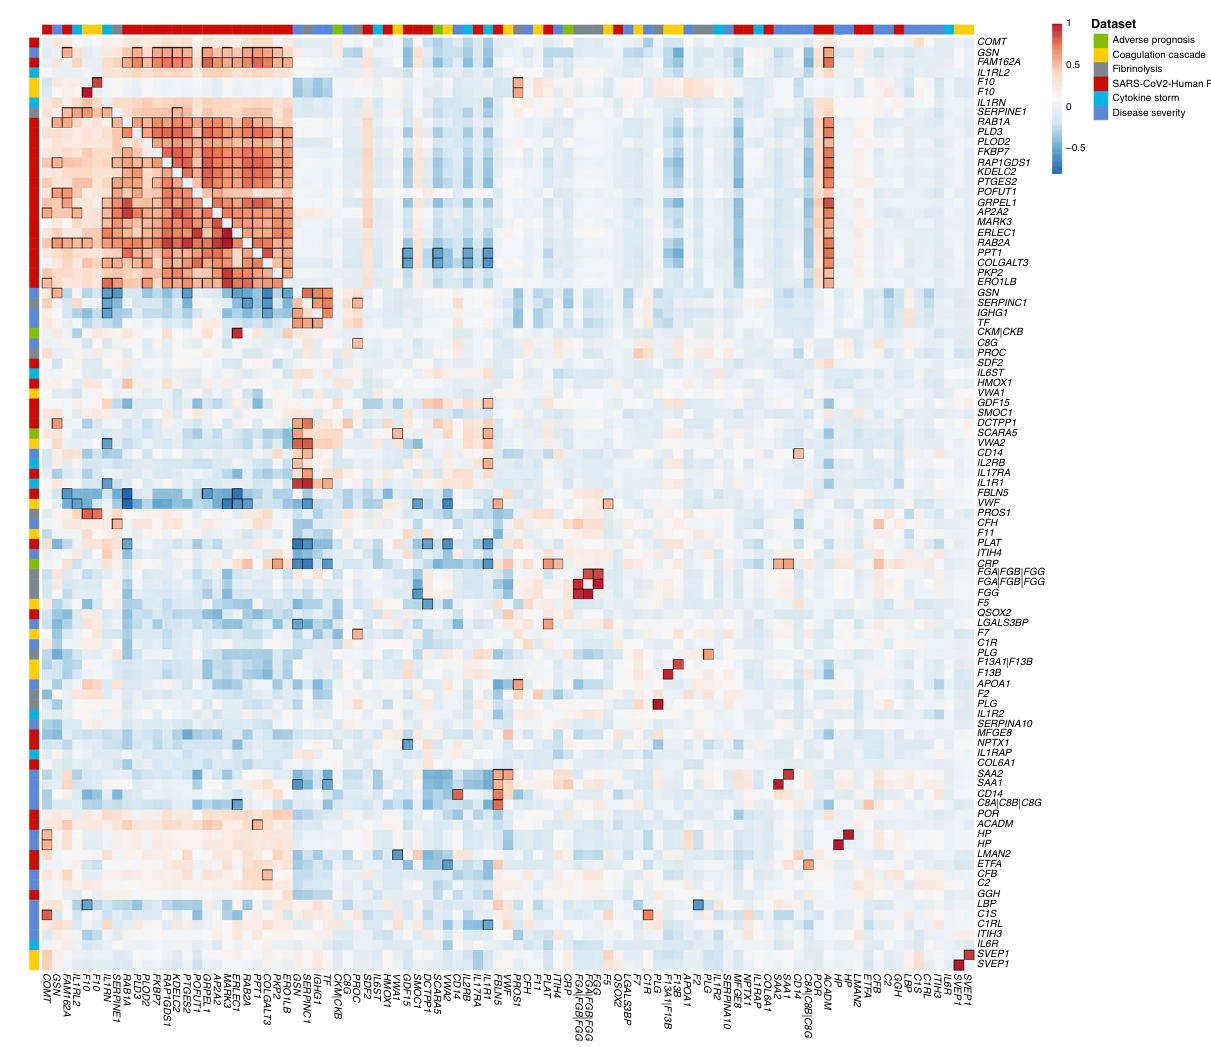
Fig. 3 Genetic (lower triangle) and observational (upper triangle) correlation matrix of 86 unique proteins targeted by 93 aptamers with reliable heritability estimates (see Methods). Aptamers were clustered based on absolute genetic correlations to take activation as well repression into account and protein-encoding genes were used as labels. The column on the far left indicates relevance to SARS-CoV-2 infection. Strong correlations (| r | > 0.5) are indicated by black